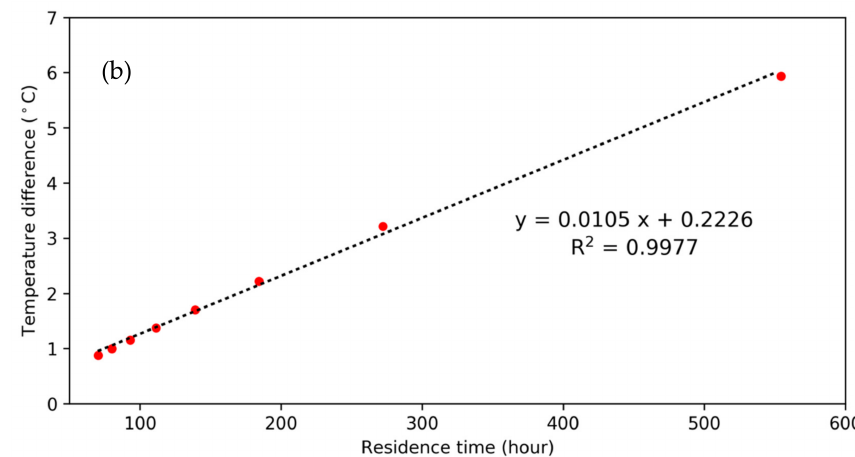
Figure 13. ( a ) Relationship between outflow rate and water temperature difference (outflow minus inflow); and ( b ) relationship between residence time and water temperature difference at the YHS.